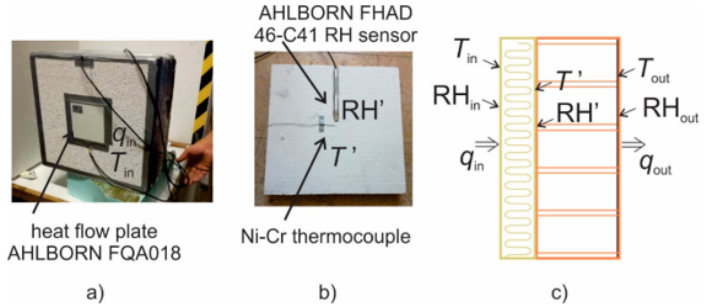
Figure 3. Heat flow plate on the interior insulation ( a ), temperature and RH meters in the interstitial layer ( b ), and a scheme with the symbols of all measured quantities ( c ).